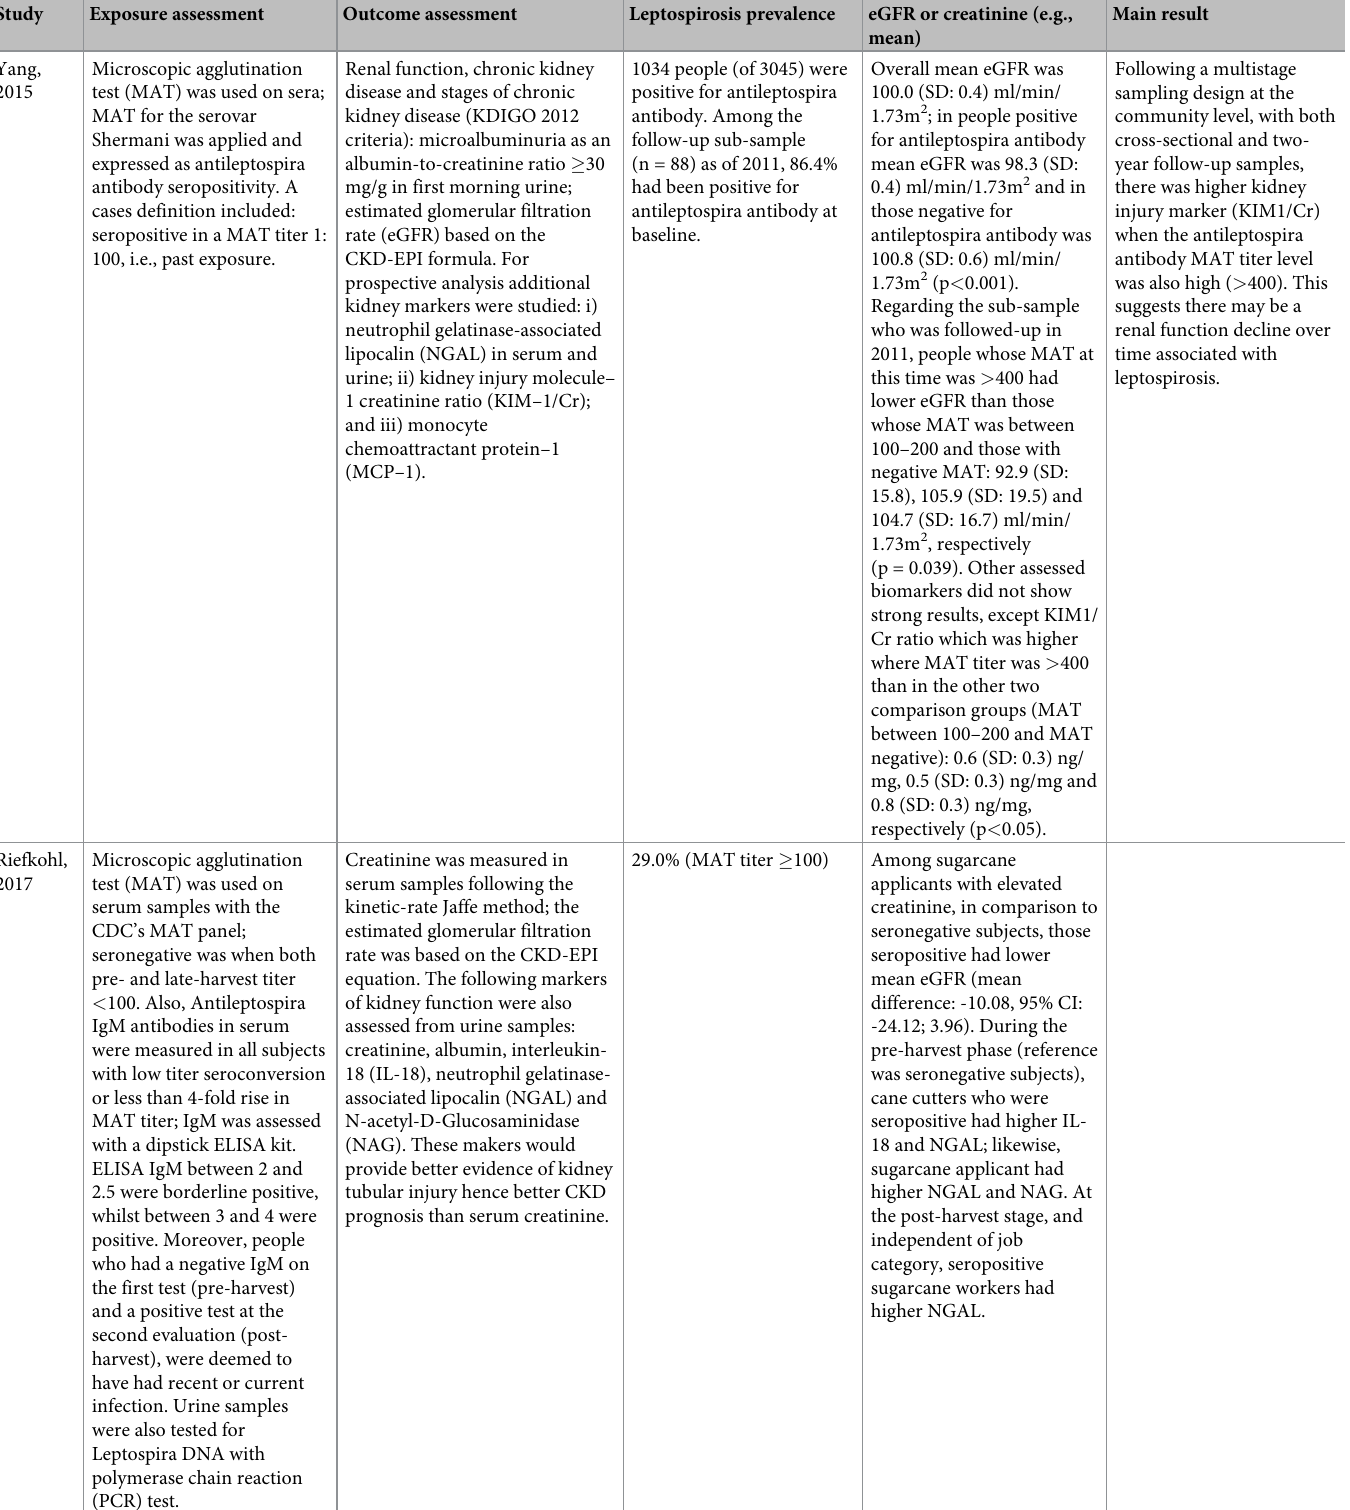
Table 2. Exposure and outcome ascertainment in the selected reports and main